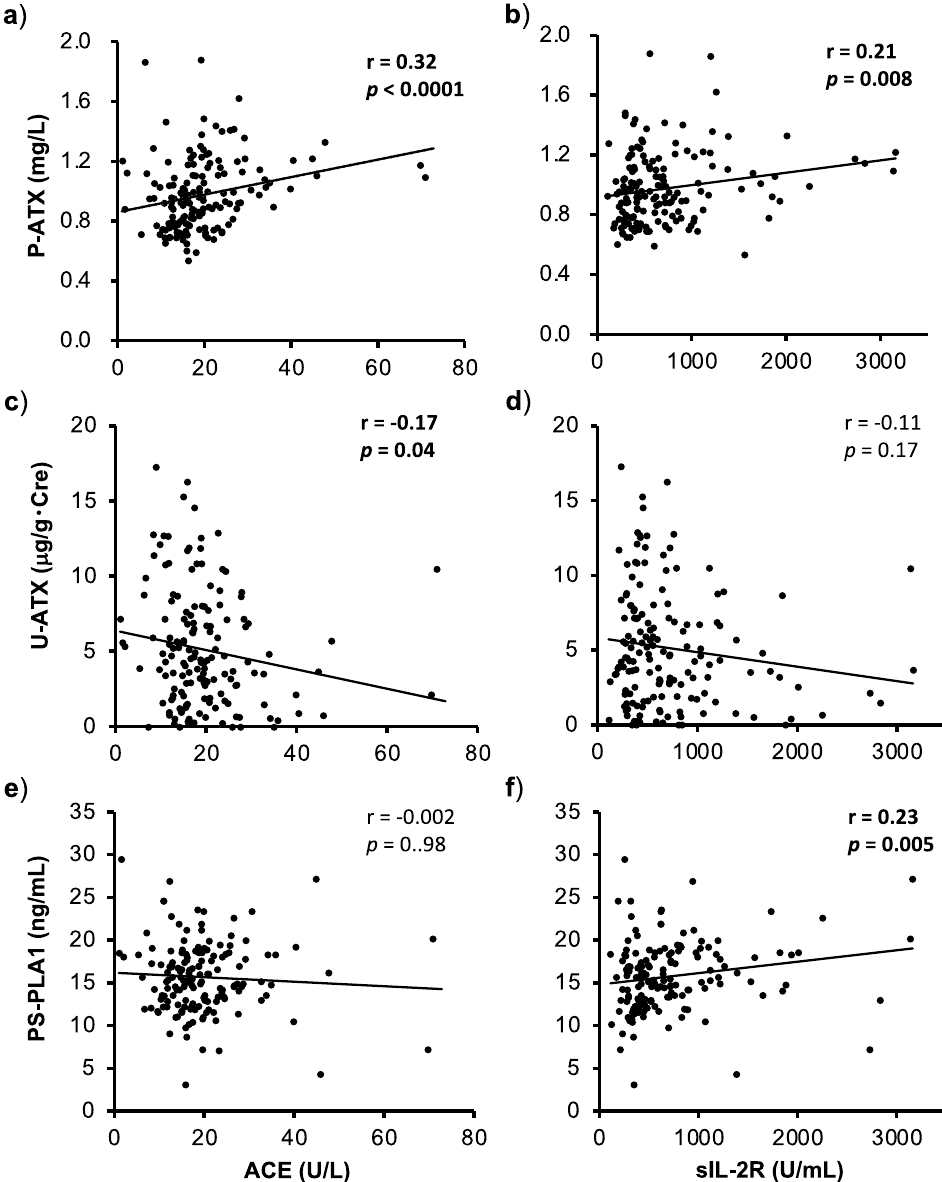
Figure 2. Correlations between LPLs-producing enzymes and clinically used diagnostic biomarkers for sarcoidosis. Correlations between ACE or sIL-2R and P-ATX ( a , b ), U-ATX ( c , d ) and PS-PLA1 ( e , f) . Data were statistically analyzed by the Spearman’s rank test. Bold denotes values p <